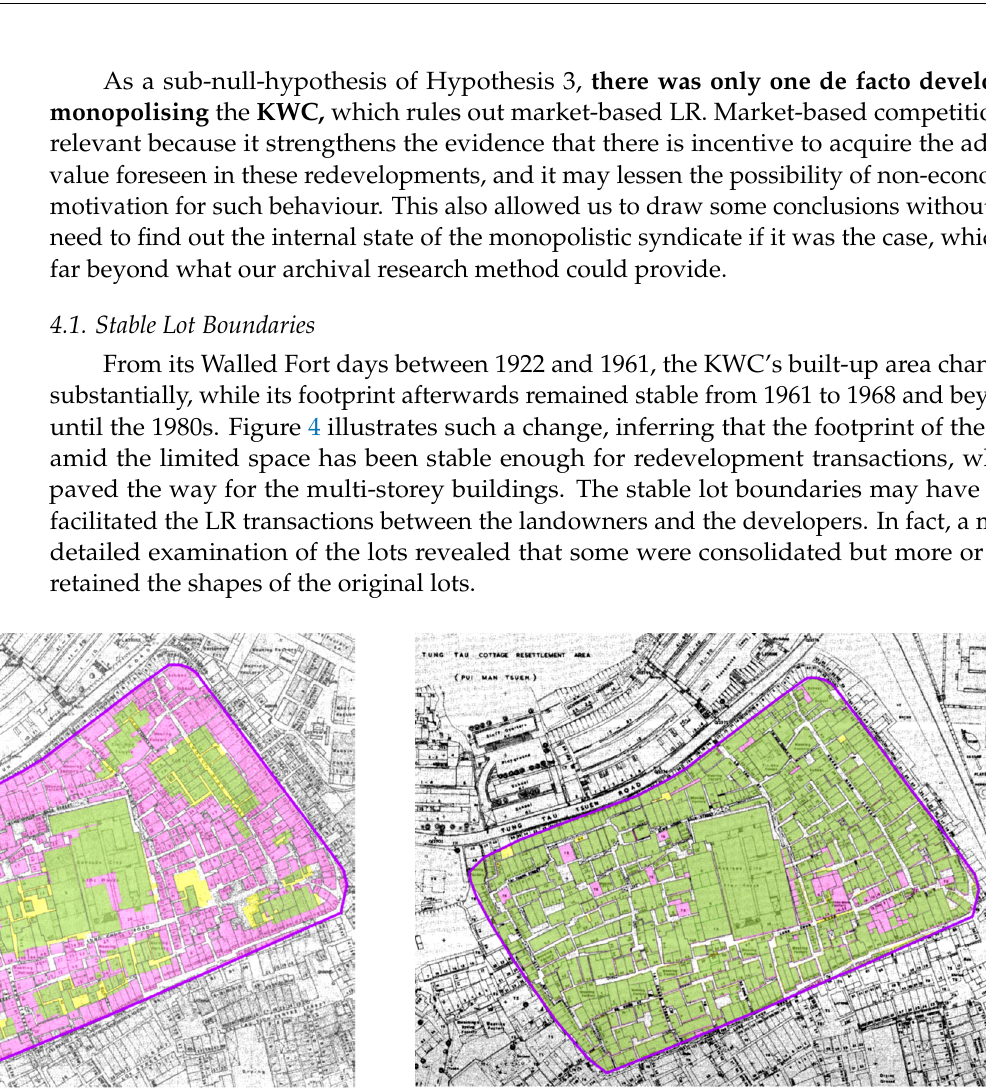
Figure 4. In pink, changes in property boundaries (footprint) between 1922–1961 ( left ) and 1961–80s ( right ) within KWC (adopted from the work of Lai et al. [23]).